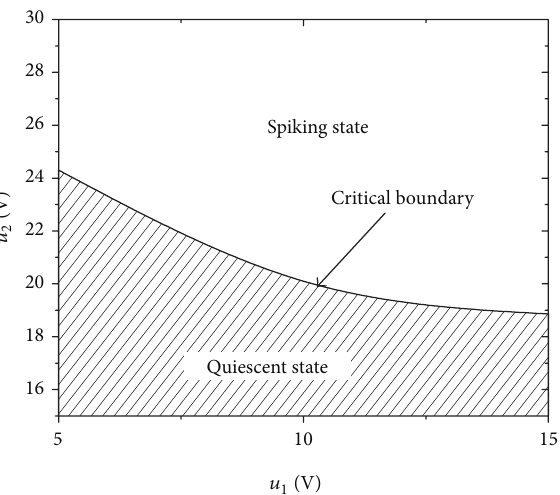
Figure 13: Critical boundary between SP and QS with 𝑢 2 − 𝑢 1